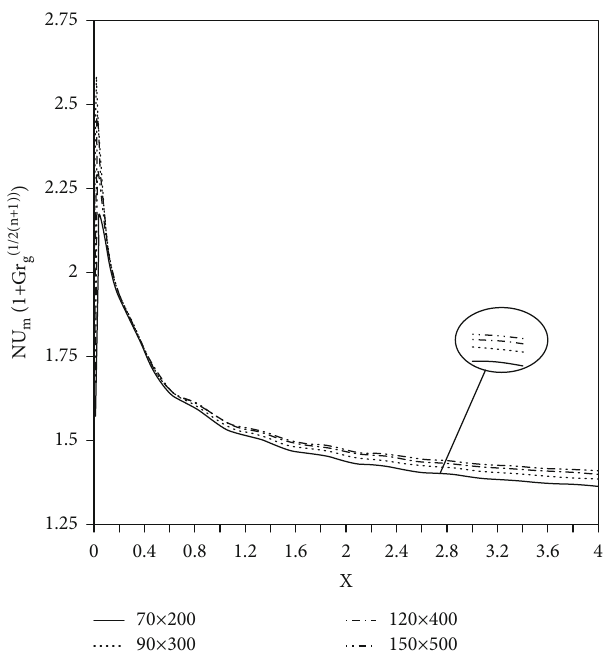
Figure 2: Mean Nusselt number for the grid independence test.